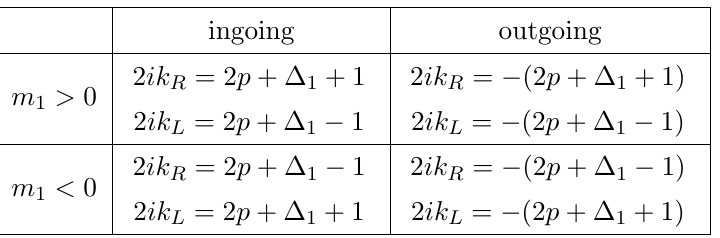
Table 3 . Spin-1 quasinormal mode spectrum after imposing standard Dirichlet boundary condi- tions. When (cid:1) 1 = 3 these correspond to the spectrum of transverse ghost modes which appear in the graviton one-loop determinant (2.30). Each condition on k R or k L labels a distinct eigenmode and the range of p is over all non-negative